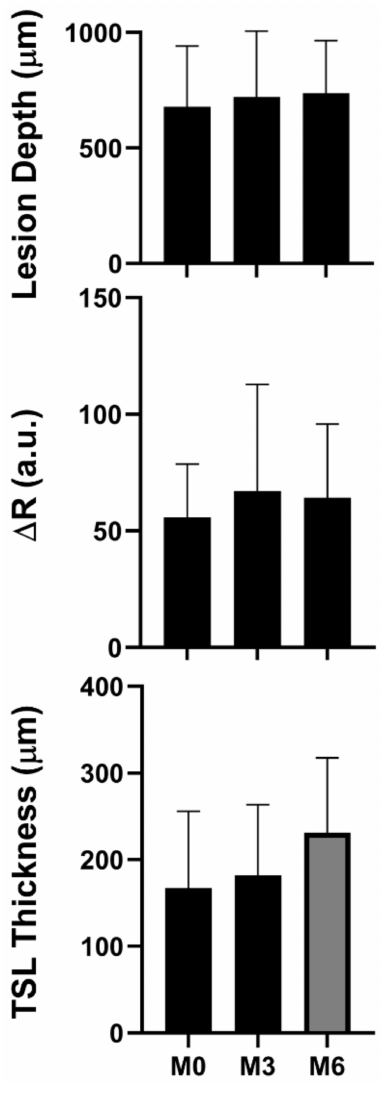
Figure 6. Bar graphs for mean ± S.D. for the CP-OCT measurements of the lesion depth, integrated reflectivity over the lesion depth ( ∆ R), and the TSL thickness. Bars of the same color are statistically similar ( p > 0.05). There were 22 samples for the lesion depth and ∆ R, and 9 samples that had measurable